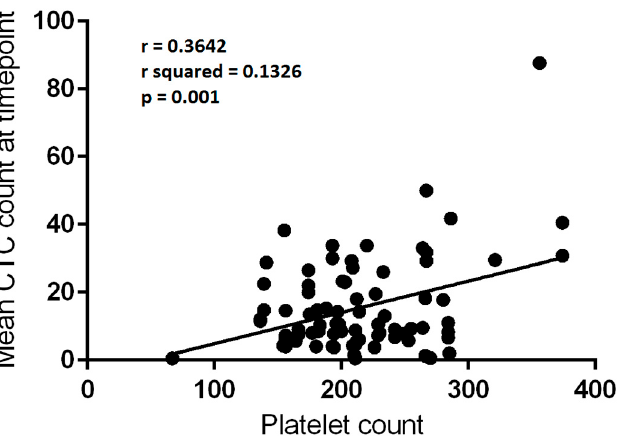
Figure 4. Correlation between platelet count (×10 9 /L) and mean circulating tumour cell (CTC) count per 3 mL of blood at a given blood draw in control group ( n = 79). Linear regression, r = 0.3642; r 2 = 0.1326; p = 0.001.